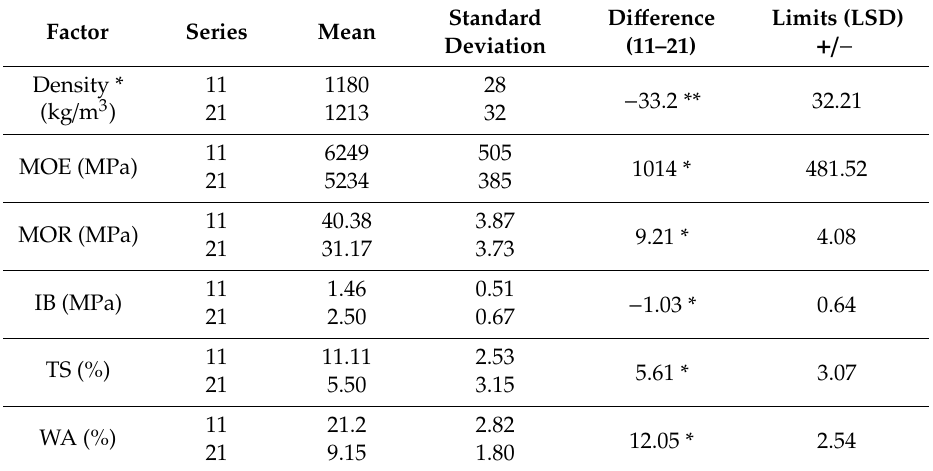
Table 2. Di ff erence of the characteristics of the boards between the series 11 and